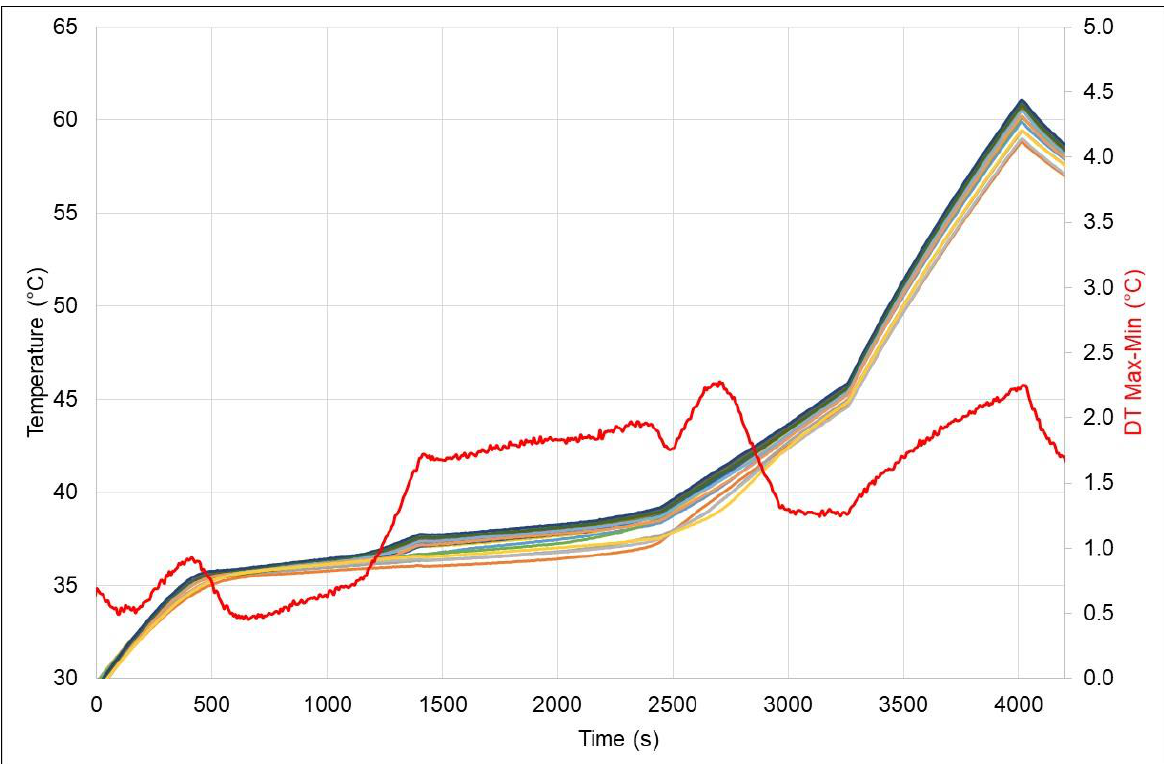
Figure 24. Experimental temperature of cell wall for repeated highway driving profiles.